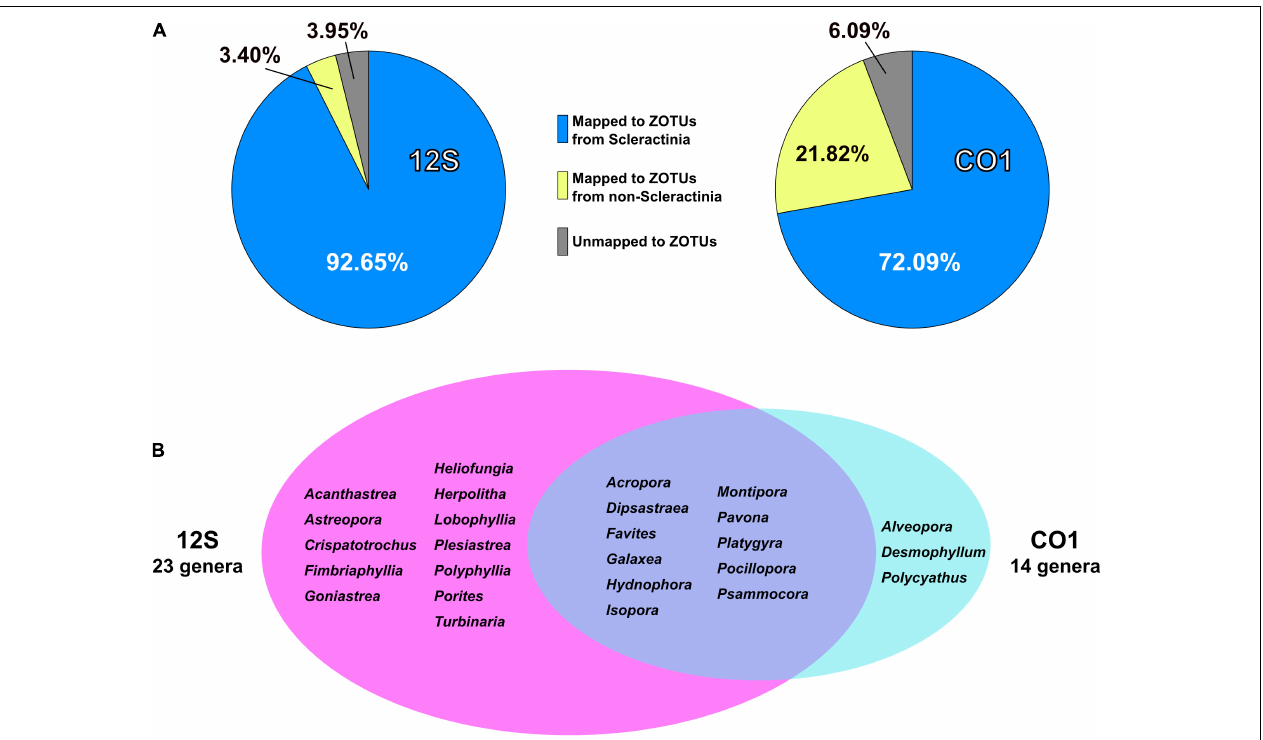
FIGURE 4 | PCR amplicon sequencing and detection of coral genera from eDNA. (A) Percentages of reads mapped to ZOTUs from Scleractinia, ZOTUs from non-Scleractinia, and none of the ZOTUs. Values are averages of six eDNA samples, and are available in Supplementary Tables 4 , 5 . (B) Numbers of coral genera detected from 12S and CO1 PCR amplicons using eDNA and comparisons of genera identified by the two primer sets. Coral genera with more than 0.1% of all mapped reads in each sample are